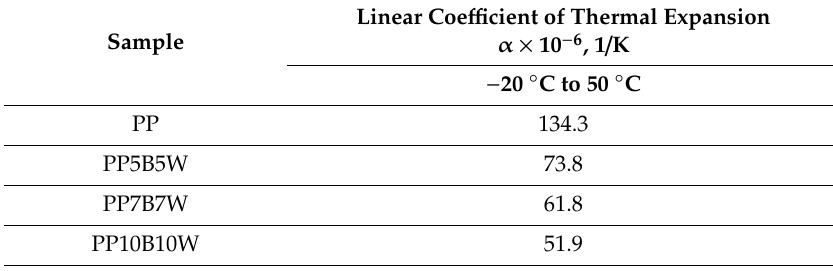
Figure 6. Thermal expansion curves of the tested composites. Table 4. Linear coe ffi cient of thermal expansion of tested